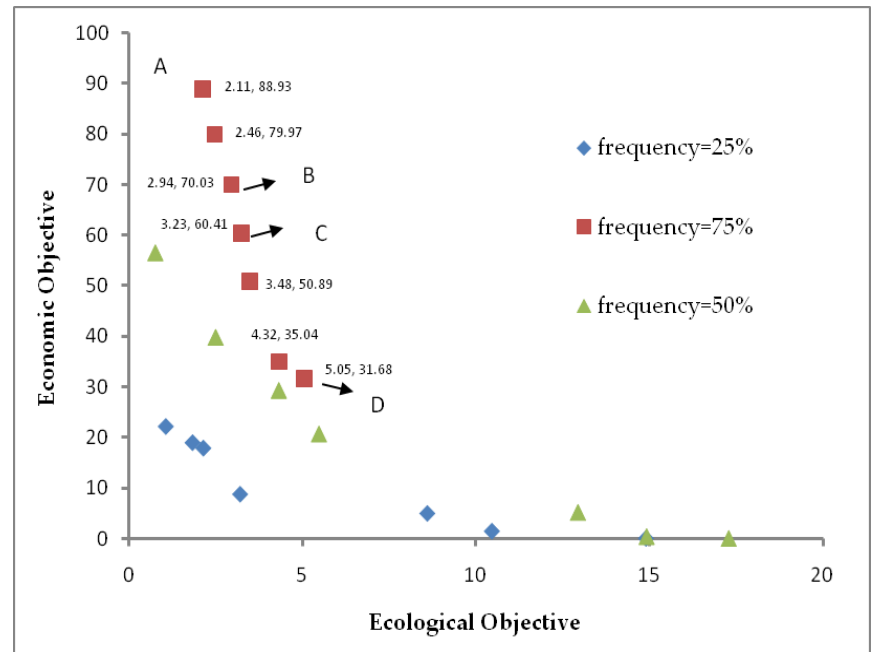
Figure 5. Trade-offs between economic and ecosystem objectives.